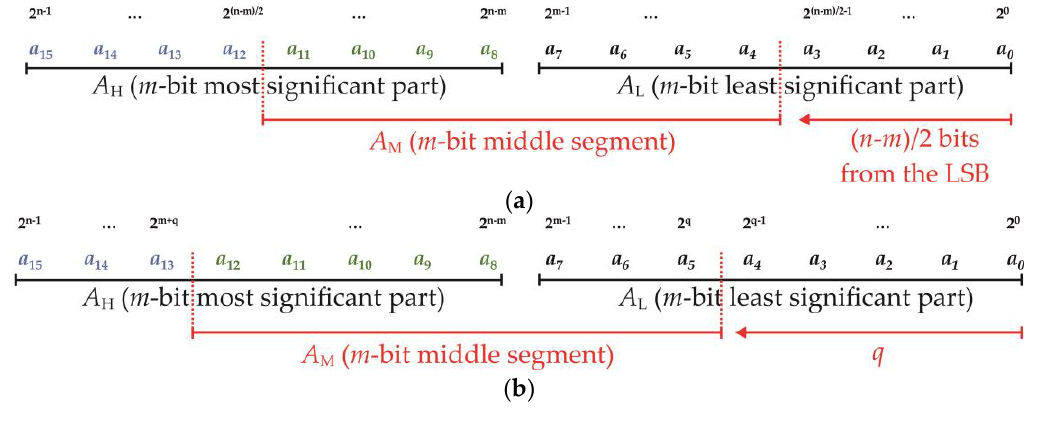
Figure 3. Segmentation of the input A in the case n = 16 and m = 8 with ( a ) the ESSM method of [29] and ( b ) the proposed generalized ESSM method in the case q = 5.